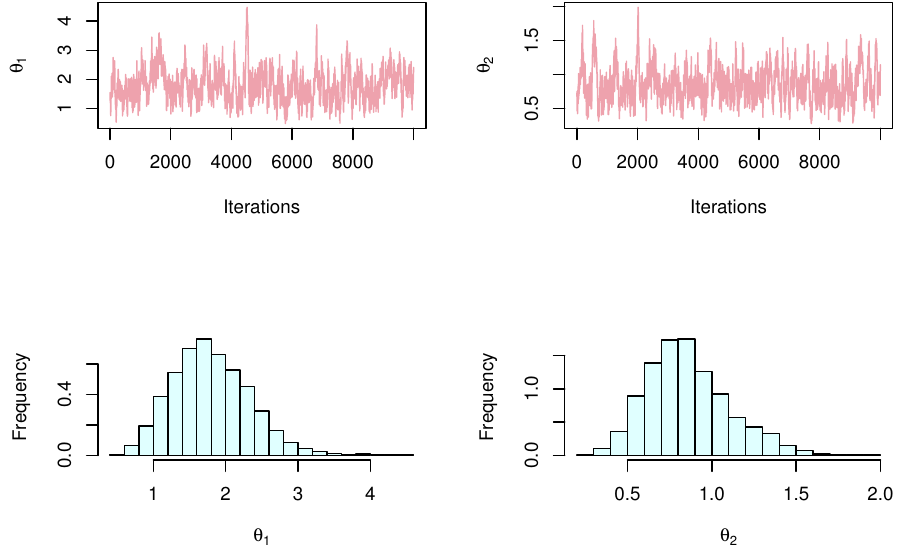
Figure 12. MCMC plots of parameter estimation by RSS method for failure times of insulating fluid